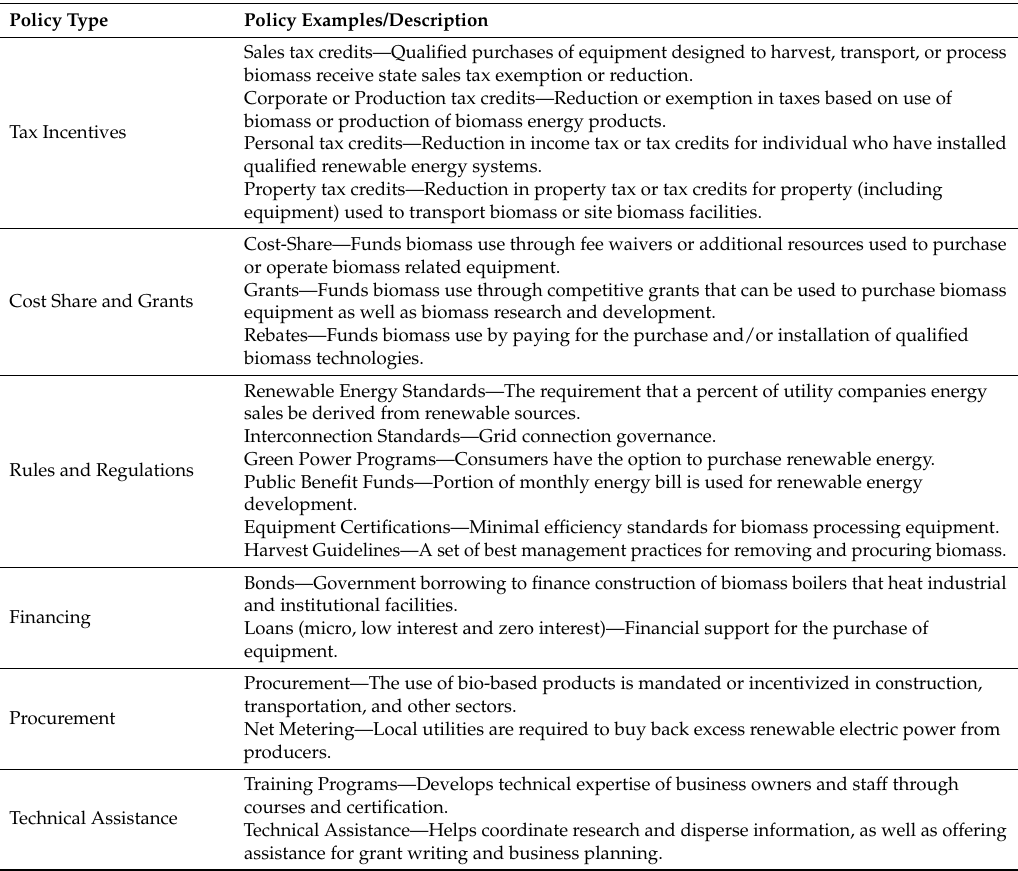
Table 1. Policy instruments encouraging the use of woody biomass, derived from Becker et al.